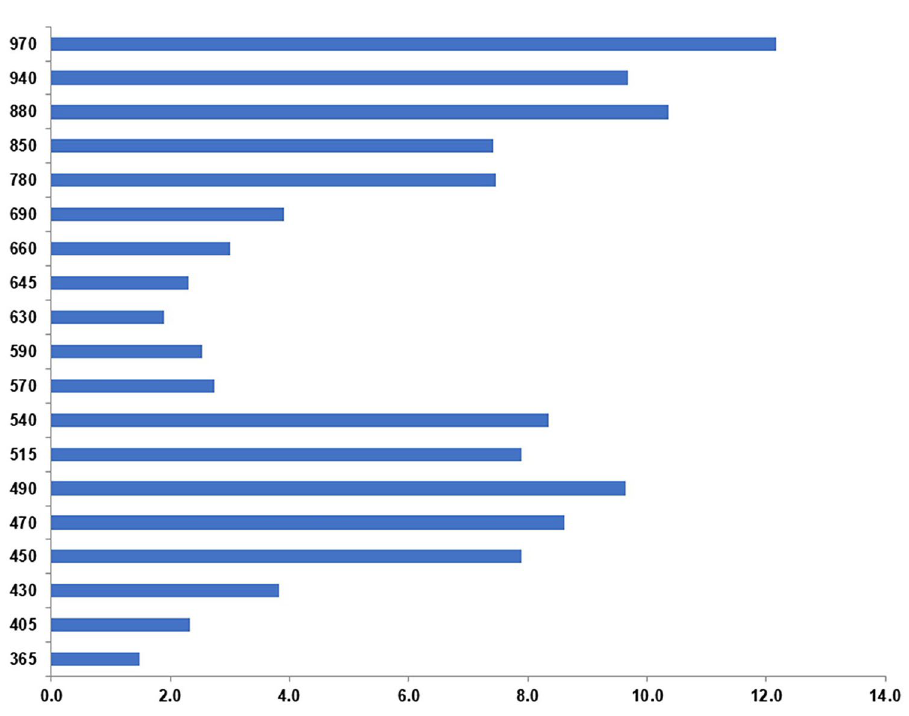
Figure 4. Difference in reflectance intensity between control and contaminated seed samples in the range 350–970